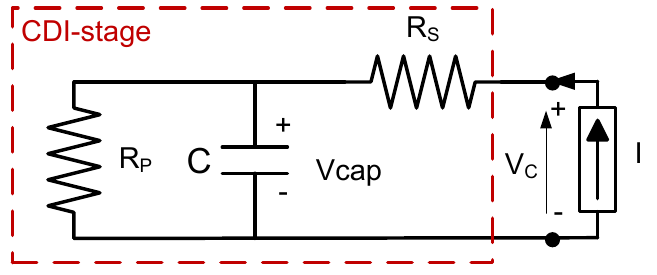
Figure 3. Electric circuit used for the parasitic determination.